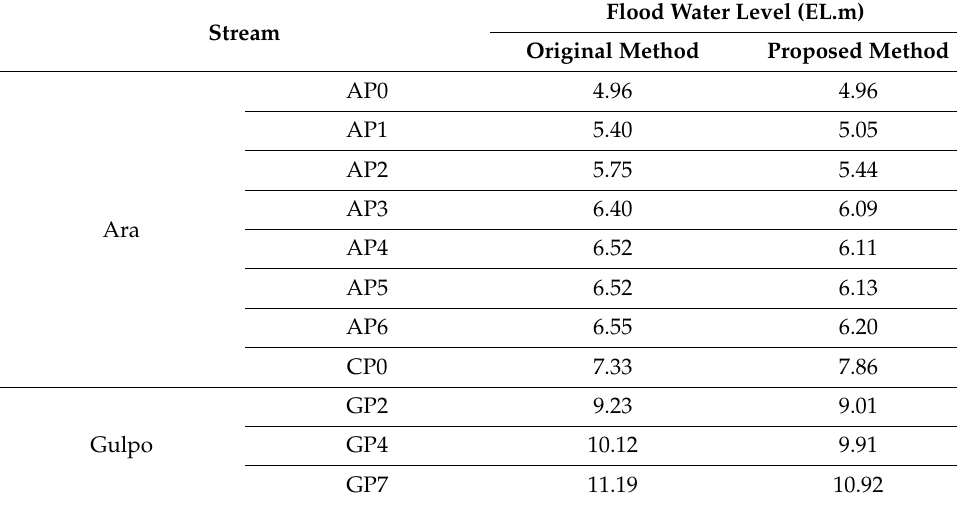
Table 8. Flood Water Level Comparison (100 Year